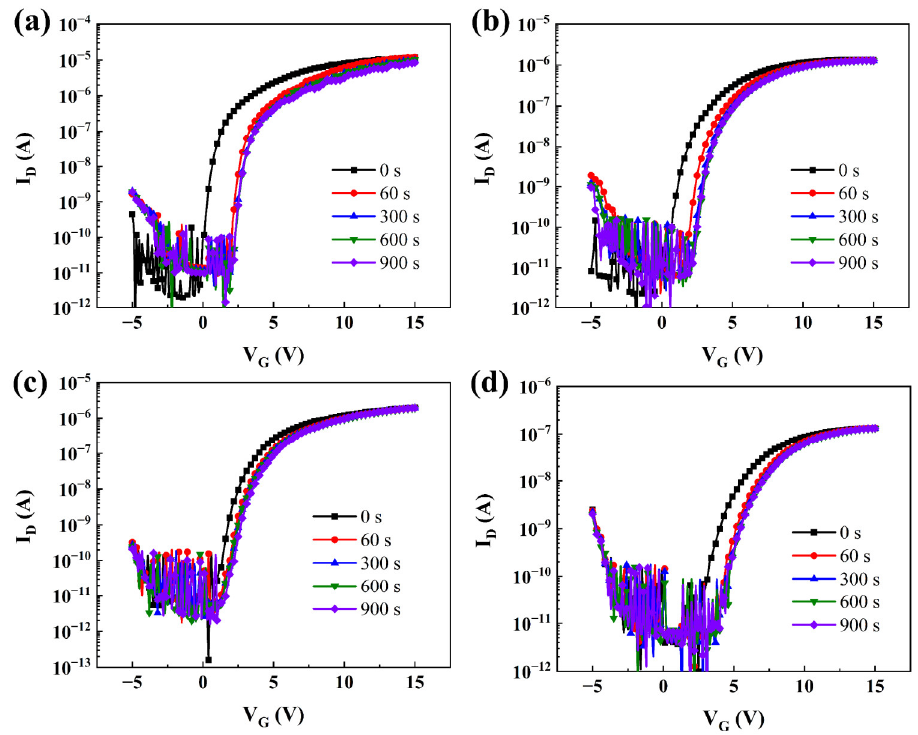
Figure 5. PBS of TaZnSnO TFTs with different Ta 5+ doping contents, ( a ) 0, ( b ) 0.5, ( c ) 1, and ( d ) 2 mol%. Table 1. Electrical performance of the TaZnSnO TFTs with different Ta 5+ doping concentrations.